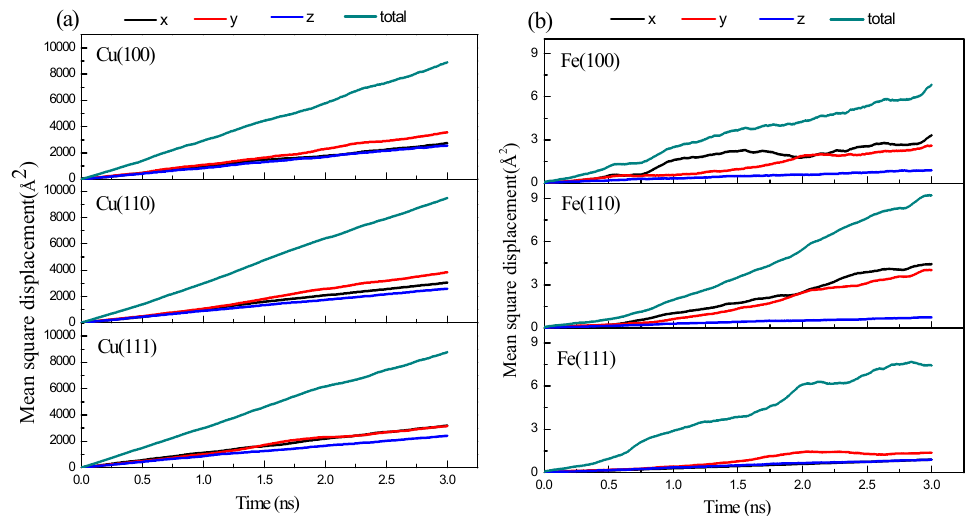
Figure 4. The mean square displacement curves of Fe/Cu interface at 1523 K with different orientation: ( a ) Cu (100), Cu (110), and Cu (111); ( b ) Fe (100), Fe (110), and Fe (100).